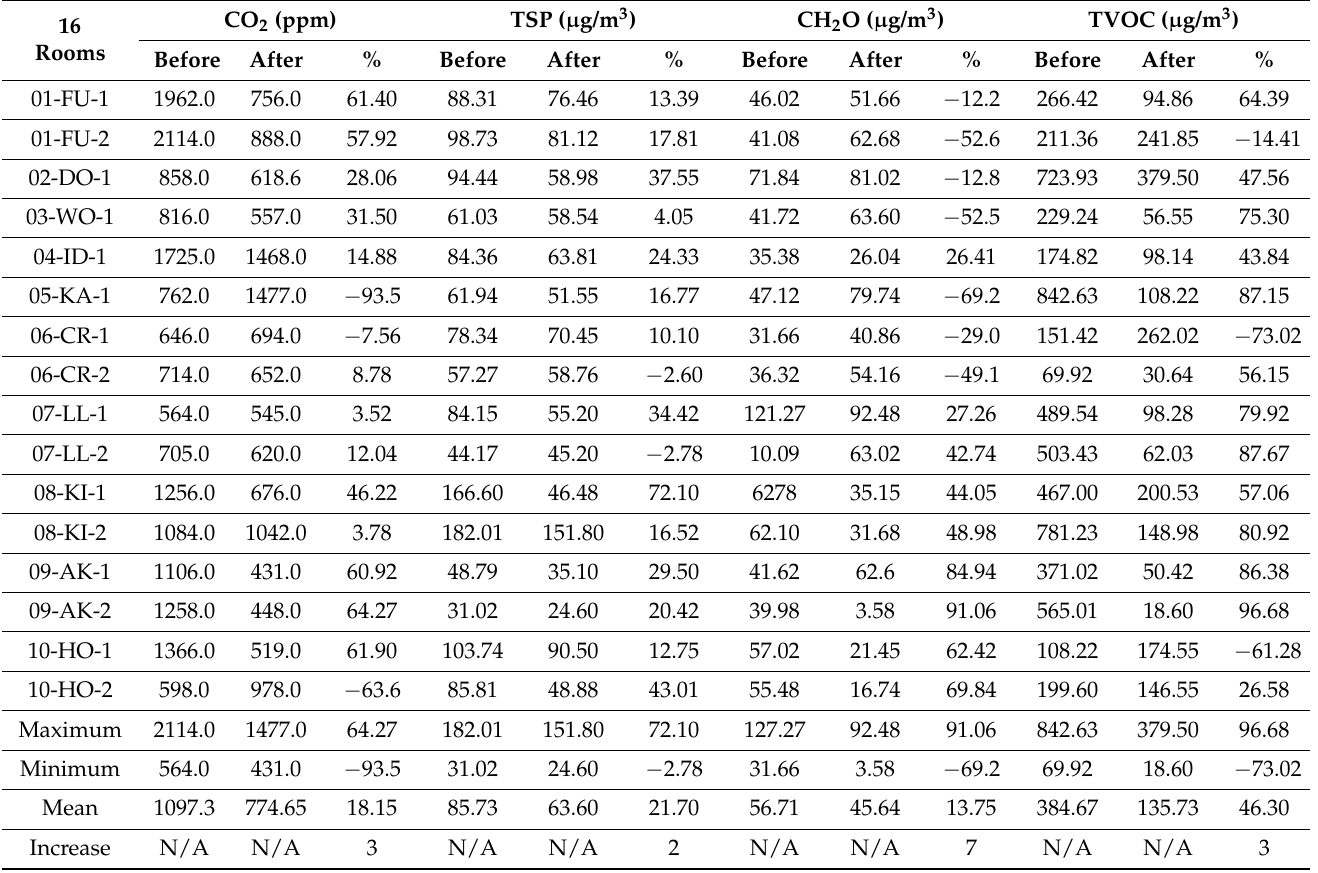
Table 4. Changes in indoor air pollutants before and after improvement with air